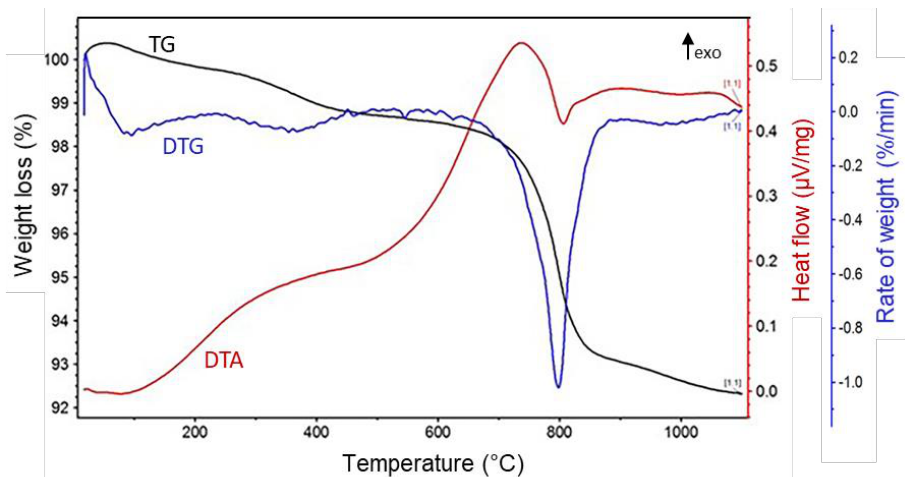
Figure 4. TGA and DTA curves of the Moroccan natural phosphate used for ceramic supports.